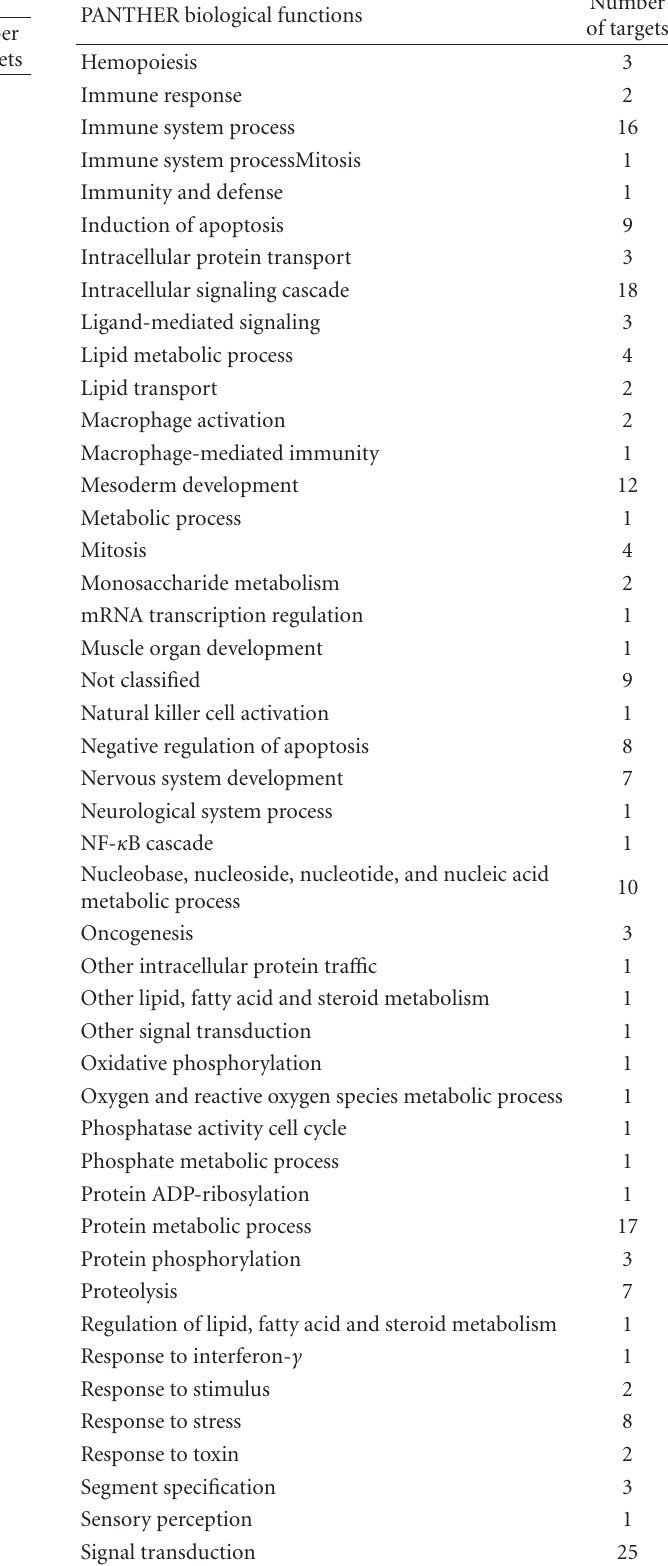
Table 4: Distribution of berberine’s targets in vitro according to biological functions.